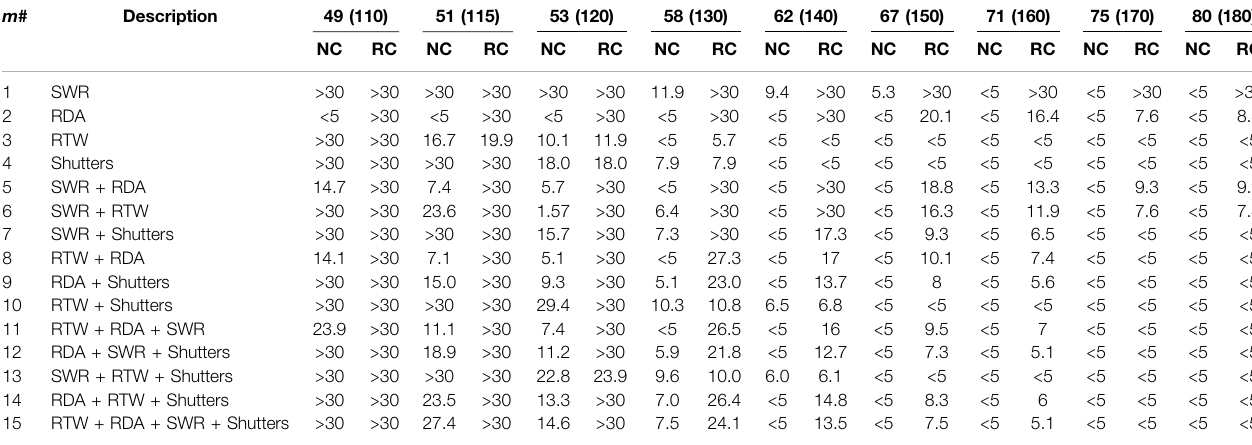
TABLE 4 | Payback period (in years) of mitigation strategies by wind contour, m/s (mph), for new construction (NC) and retro fi t construction (RC).